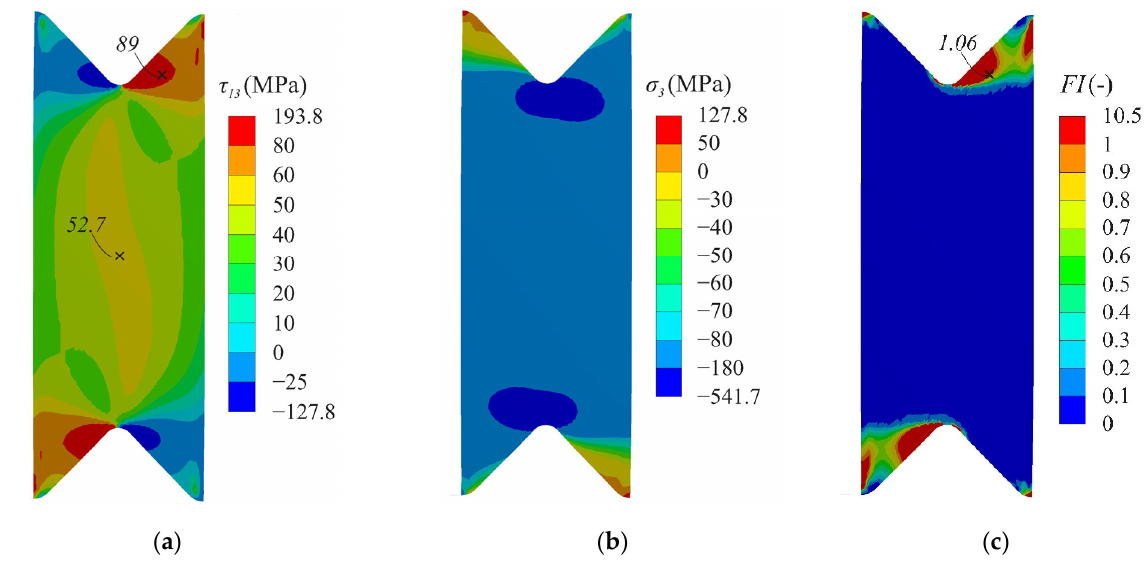
Figure 9. Distribution of interlaminar shear stresses ( a ), through-thickness stresses ( b ) and failure indexes NU-Daniel ( c ) on the face surface of the specimen at loading angle α = 15°.